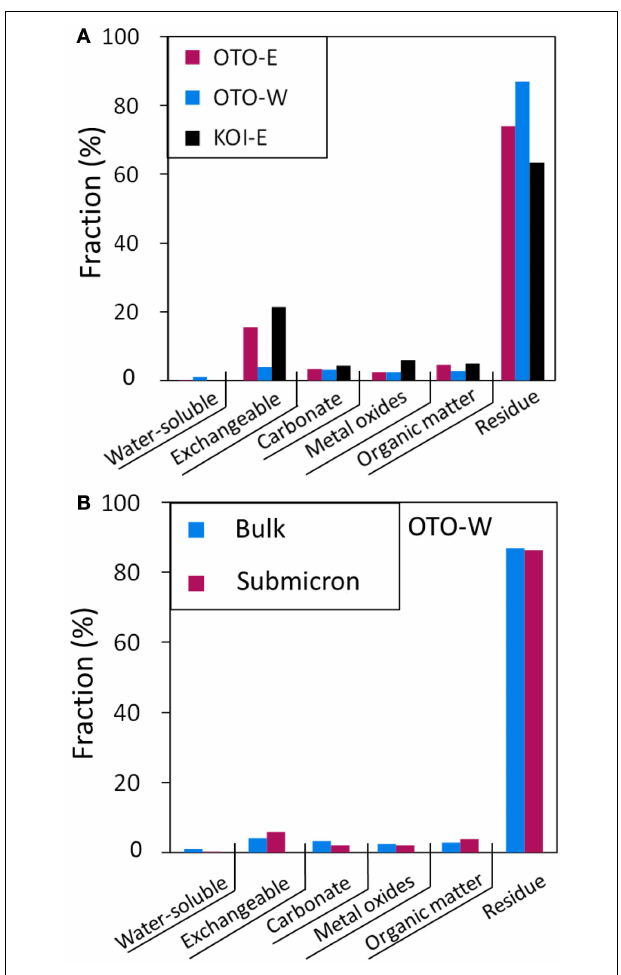
FIGURE 8 | (A) Fraction of the Cs chemical form in three soil samples determined by a sequential extraction. (B) Fraction of Cs chemical form in the submicron-sized particle elutriated from OTO-W as compared to that in the bulk OTO-W